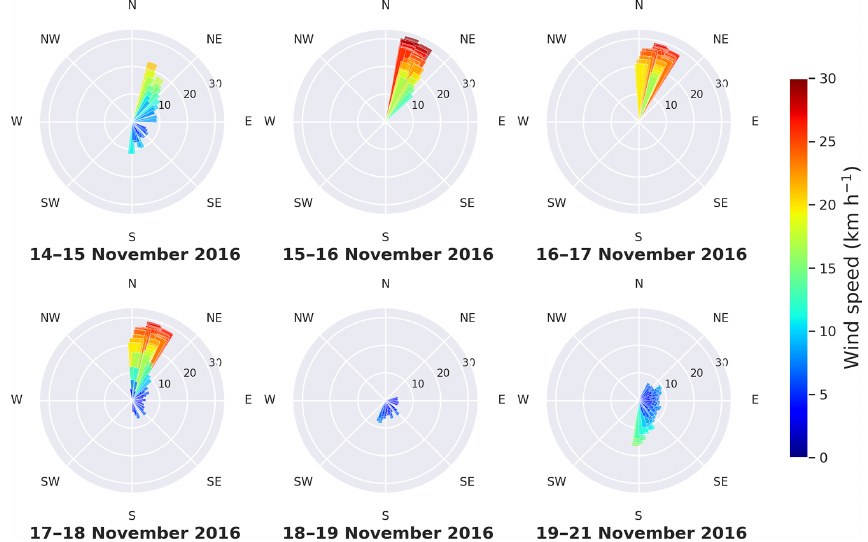
Figure 12. Maps of the 10m level wind vectors (kmh − 1 ) from the ERA5 reanalysis. Each panel has vectors from the four grid points surrounding the location of ice floe no. 29 every 3h during the time between the daily overpasses of Sentinel-1. For example, the 14– 15 November panel has the 3h vectors between the acquisition times of 14 and 15 November.